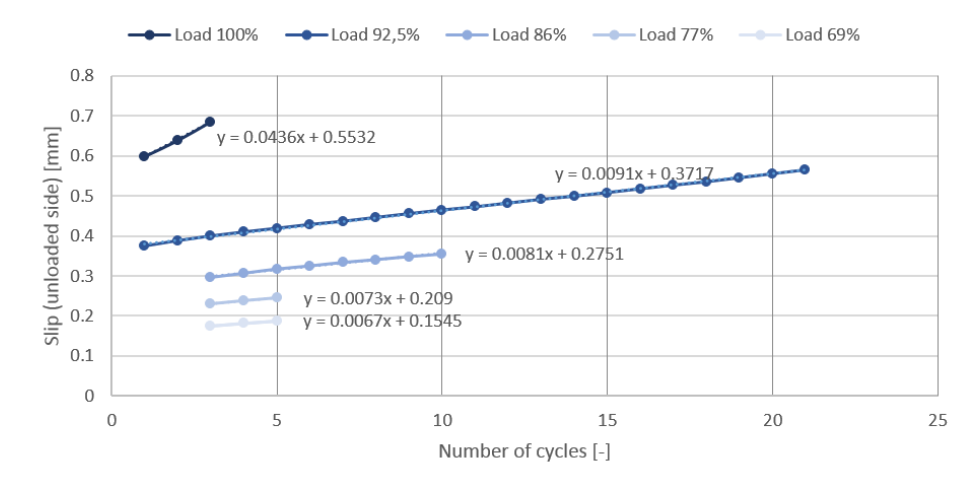
Figure 4. Linear slip (damage) development with the number of cycles under different load